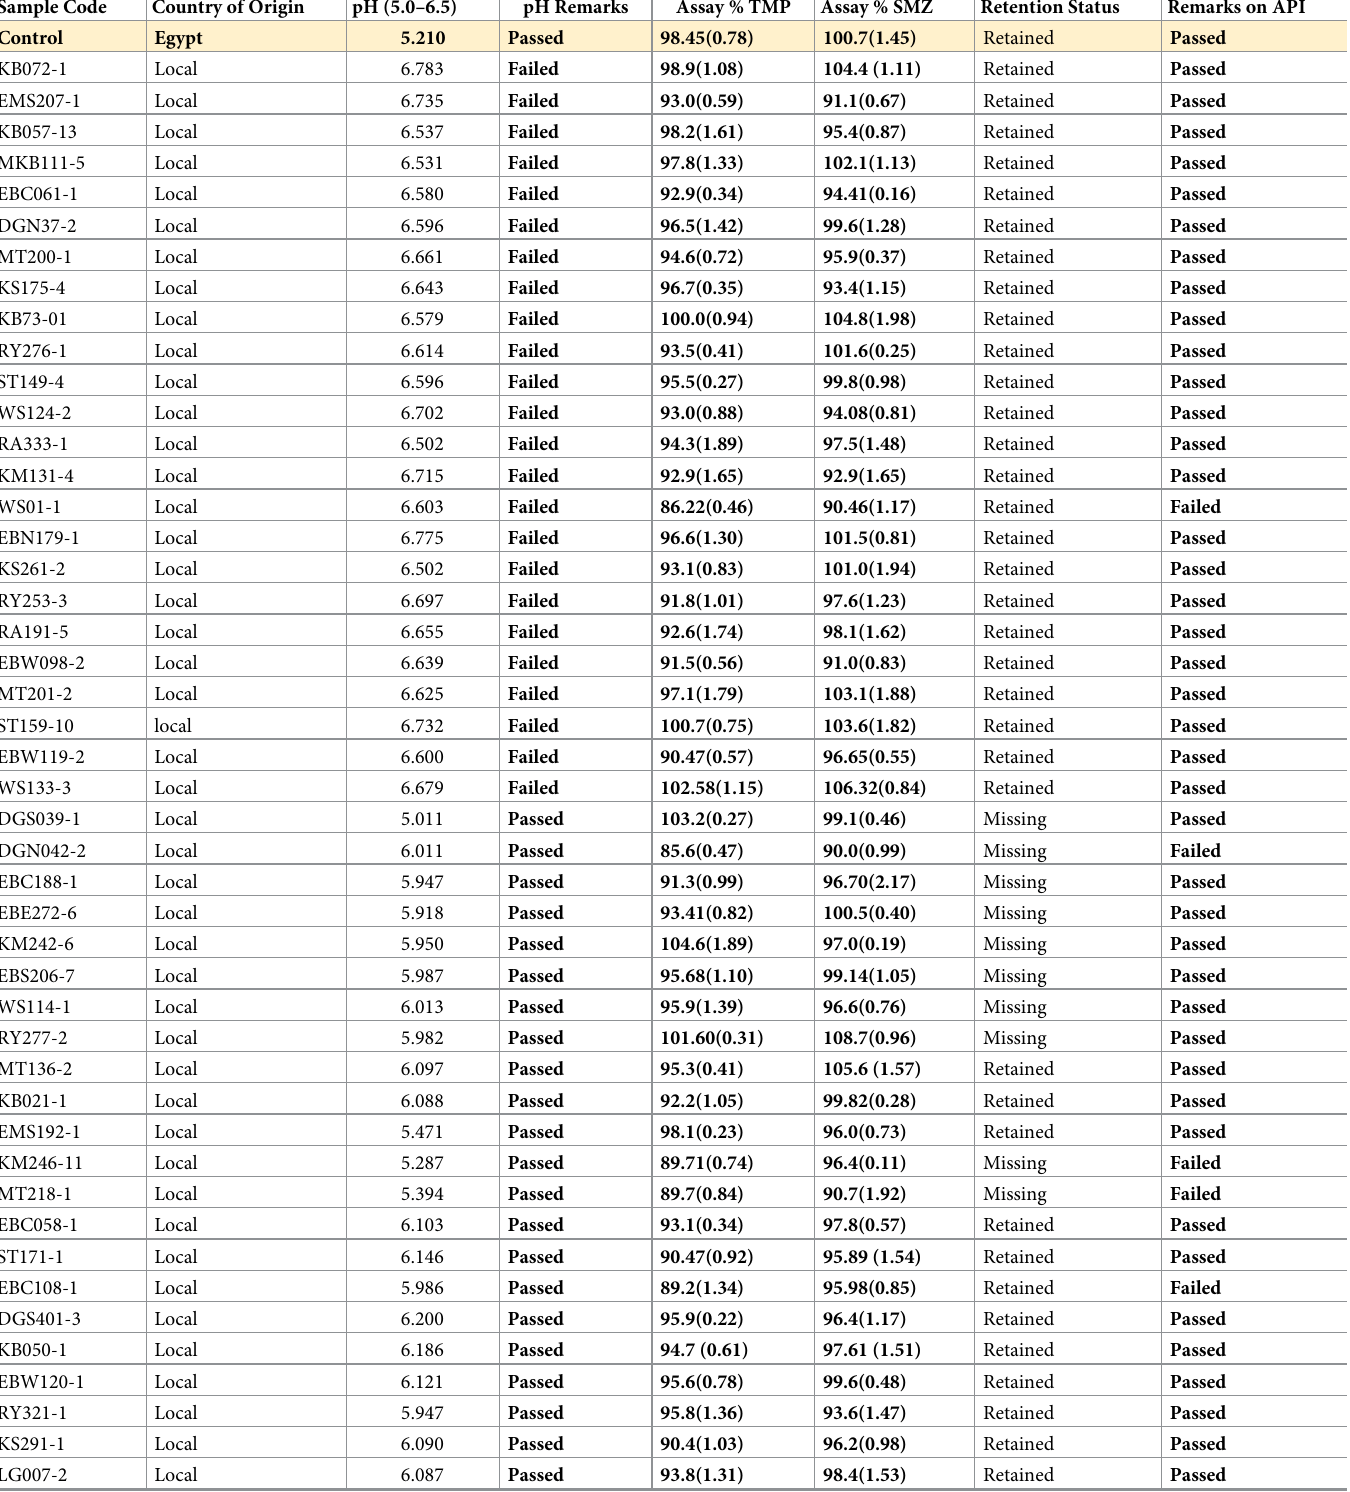
Table 2. Results for active pharmaceutical ingredient, pH and retention status. Sample